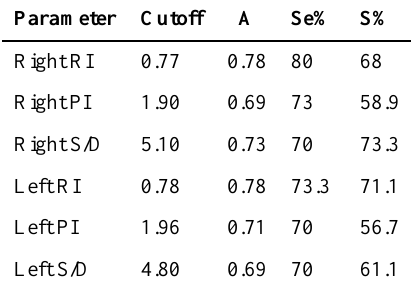
Table 3: Coordinates of the ROC Curve of Doppler parameters for prediction of missed miscarriage in early pregnancy.